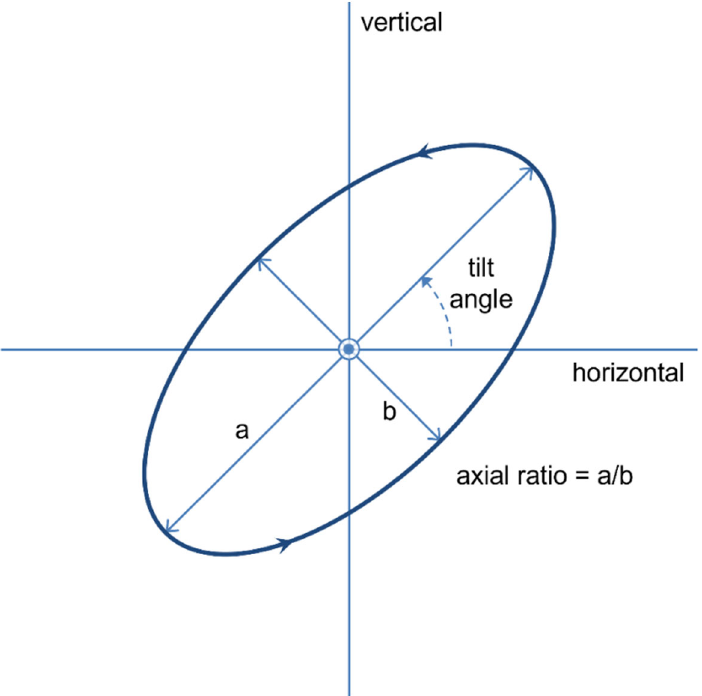
Figure 4. The key parameters of the polarization ellipse of an incoming wave, illustrating the definitions of axial ratio and tilt angle. The wave direction is out of the page towards the viewer. The arrows on the ellipse show a right ‐ handed sense of rotation. The IEEE standard definitions of sense of rotation and tilt angle have been adopted; both are defined looking along the direction of travel of the wave away from the transmitter.